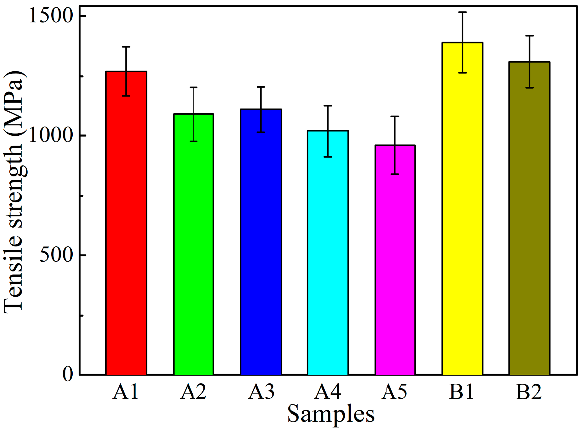
Figure 10. Tensile strength of alumina fibers.